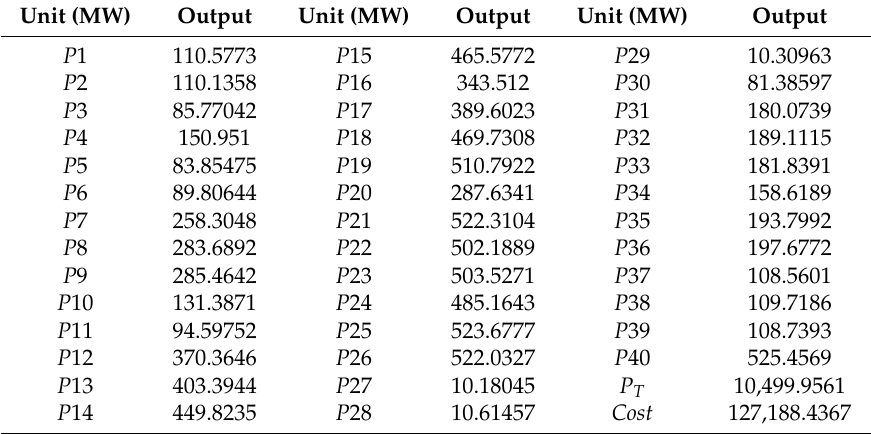
Table 13. Best solution achieved by ML-CLPSO-AM on a 40-unit